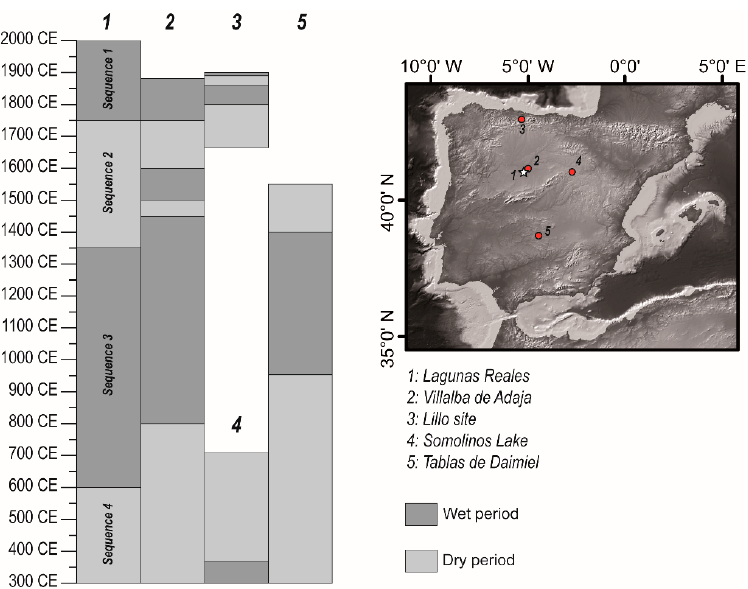
Figure 7. Figure 7. Hydroclimate periods for nearby records in the northern (1 to 4) and southern (5) Spanish Meseta.